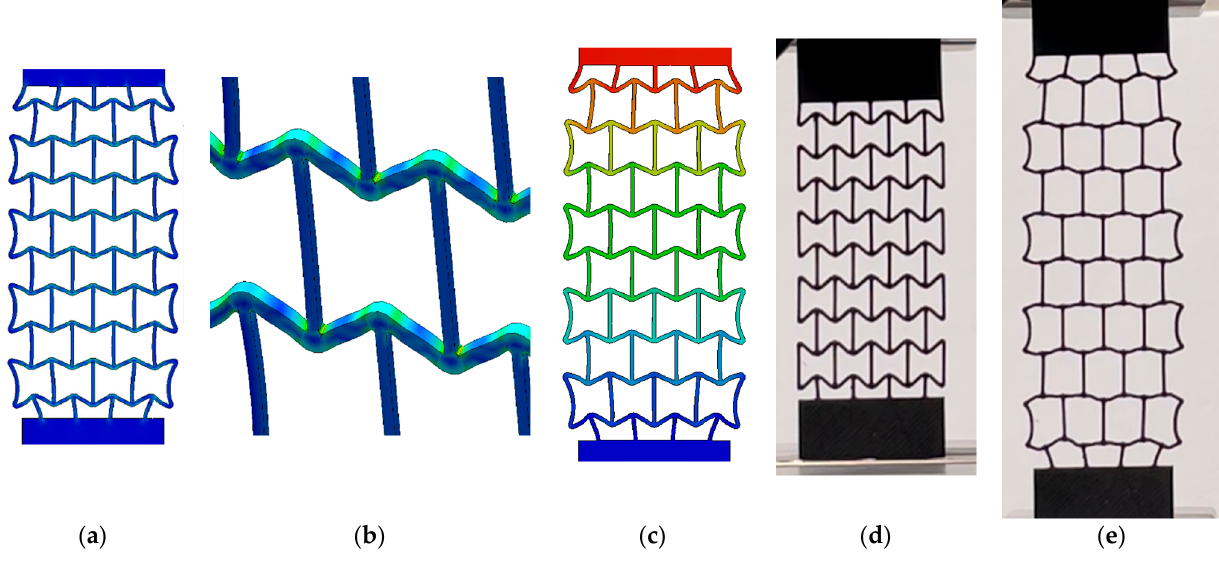
Figure 5. CRE structure with FEA, unstretched length, and stretched length: ( a ) FEA stress analysis, ( b ) FEA close-up for stress concentration, ( c ) FEA displacement, ( d ) printed structure, ( e ) stretched printed structure.